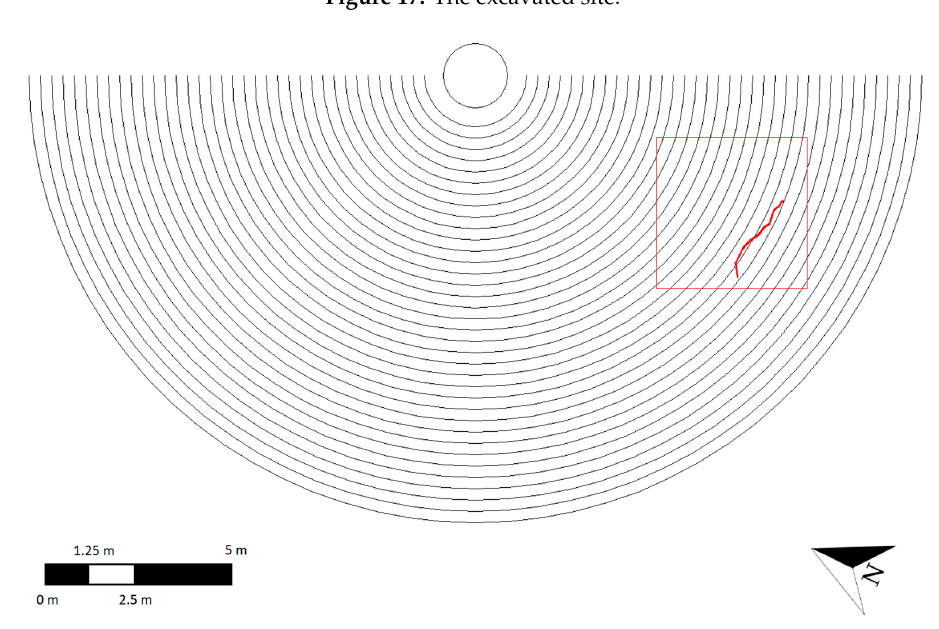
Figure 18. An outline of the survey, showing the orientation of the excavated coarse root (in red) within the test pit area. the test pit